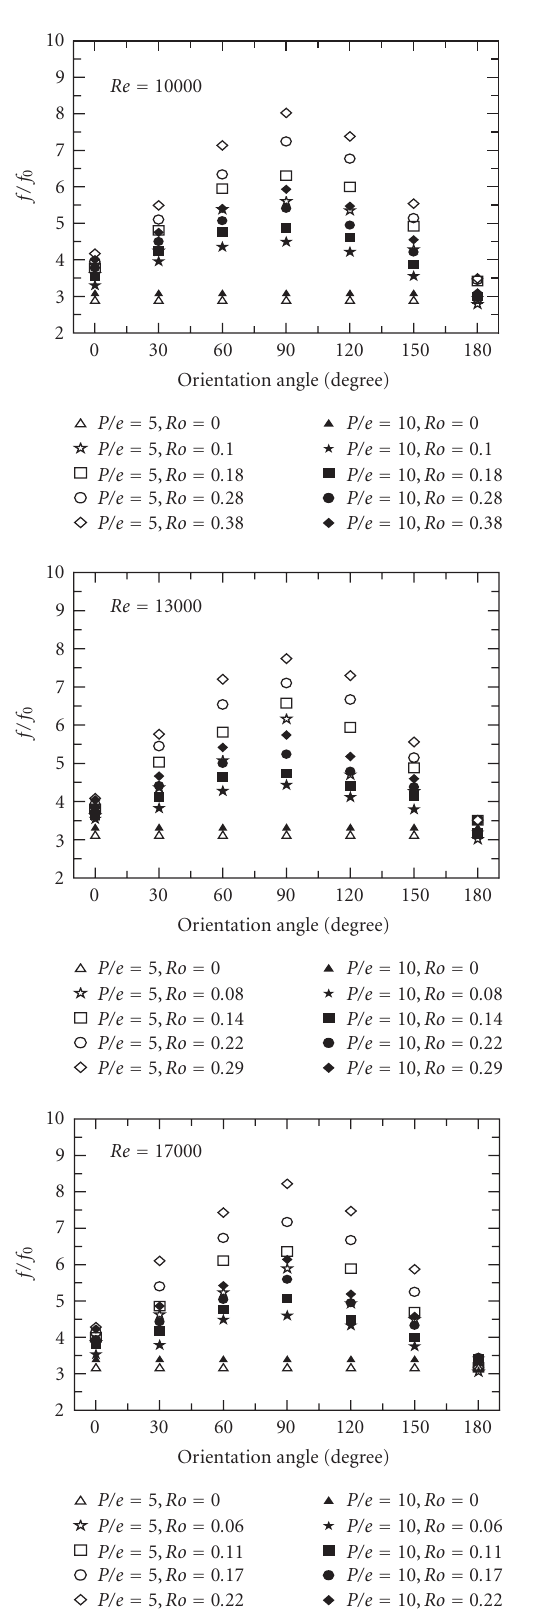
Figure 8: E ff ect of orientation angle in a rib-roughened rectangu- lar channel with attached ribs on one wall (for comparison from Sardeshpande et al.